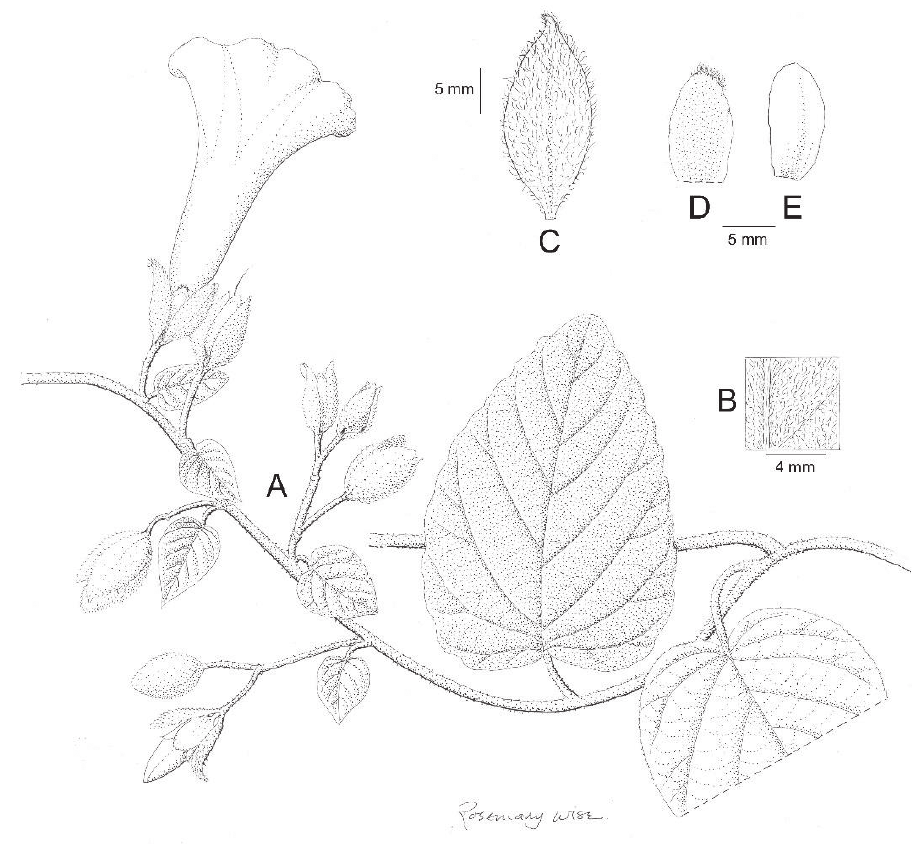
Figure 17. Ipomoea veadeirosii . A habit B abaxial leaf surface C bracteole D outer sepal e inner sepal. Drawn by Rosemary Wise: A–B from H.S. Irwin et al. 33148, C–e from W.R. Anderson et al. 6691. cro rather stout, adaxially yellow-green, tomentose, glabrescent when old, abaxially grey-tomentose, the veins highlighted; petioles 0.5–4 cm, tomentose. Inflorescence of flowers borne on axillary bracteate branchlets; bracts 2–2.5 × 1–1.7 cm, ovate, tomen- tose; cymes 1–2-flowered; peduncles 1–6 cm, tomentose; secondary peduncles pedicel-